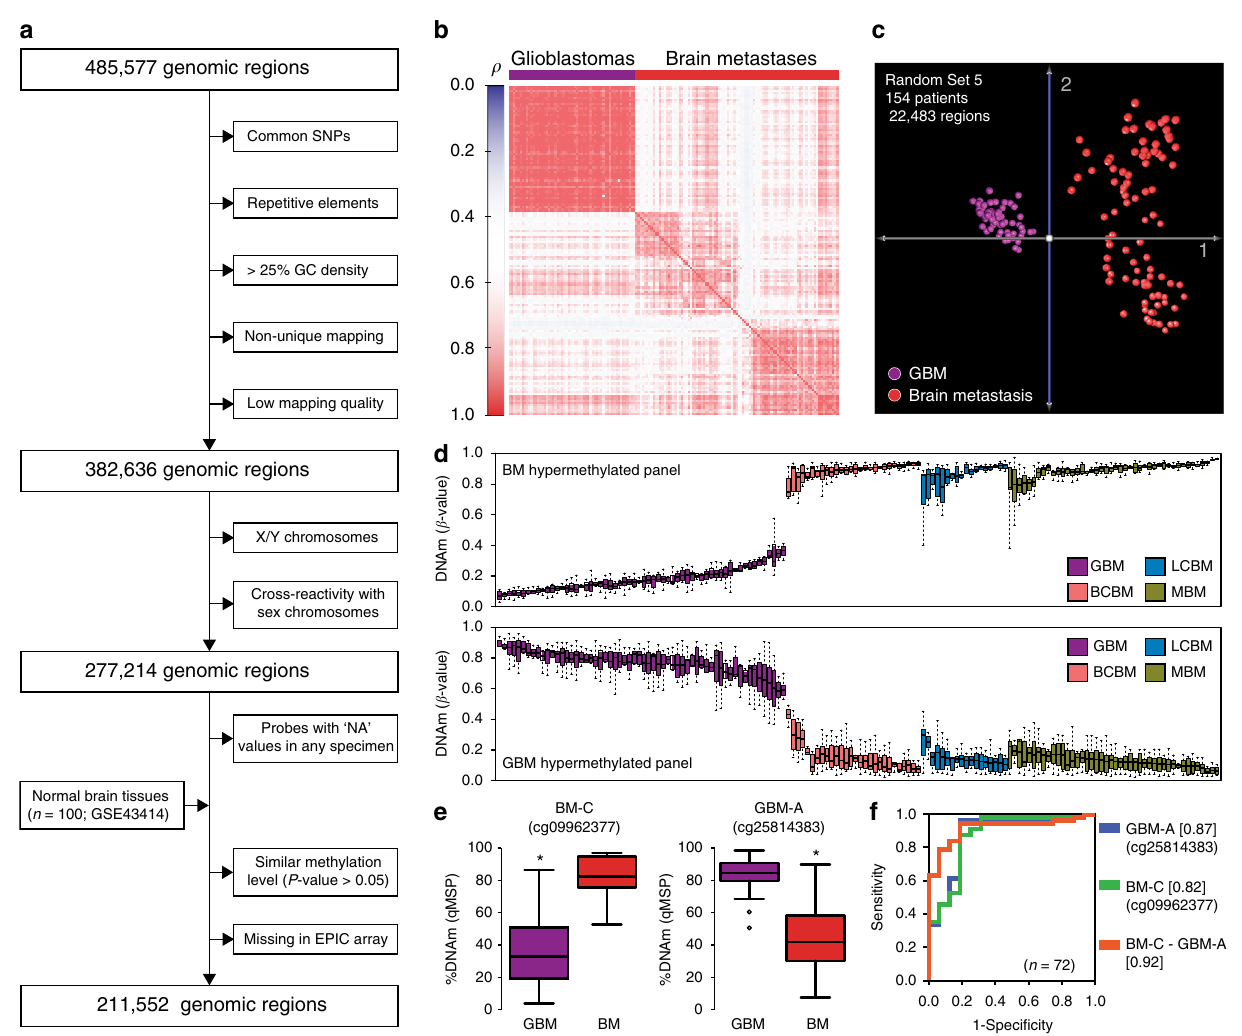
Fig. 1 Genome-wide DNA methylation pro fi ling of brain tumors. a Diagram describing the normalization algorithm of In fi nium HM450K probes. b Matrix depicting the Spearman ’ s ρ correlation coef fi cients among primary and metastatic brain tumors. c Principal component analysis (PCA) of GBM ( n = 60) and brain metastases ( n = 94) using DNA methylation level of 22,483 randomly-selected genomic regions. d DNA methylation level of the 12 most differentially methylated regions between GBM and BM specimens. The upper panel shows the β -value of six genomic regions differentially hypermethylated in BM (cg07076109, cg19111287, cg09962377, cg10982851, cg15002250, and cg23108580) and the lower panel shows the β -value of six genomic regions differentially hypermethylated in GBM (cg25814383, cg26306329, cg06663644, cg20604286, cg04314308, and cg26306994) for each specimen in the study ( n = 154). The top and bottom of each box represent the fi rst and third quartile, respectively; the internal line represents the median. e Validation of differentially methylated regions by qMSP in an independent cohort of brain tumor specimens ( n = 72). The left boxplot shows the methylation level of a genomic region hypermethylated in BM specimens (BM-C; cg09962377) and the right boxplot the level of a genomic region hypermethylated in GBM specimens (GBM-A ; cg25814383; chr19:19,336,240). The top and bottom of each box represent the fi rst and third quartile, respectively; the internal line represents the median. *Wilcoxon test, P -value < 0.02. f ROC showing the prediction potential of brain tumor type using qMSP scores for each independent genomic region and score for the combination (DNAm level of BM-C minus DNAm level of GBM-A; AUC = 0.92, 95% CI = 0.85-0.99); see Supplementary Data 3 for details about validated genomic regions. The AUC values are indicated between square